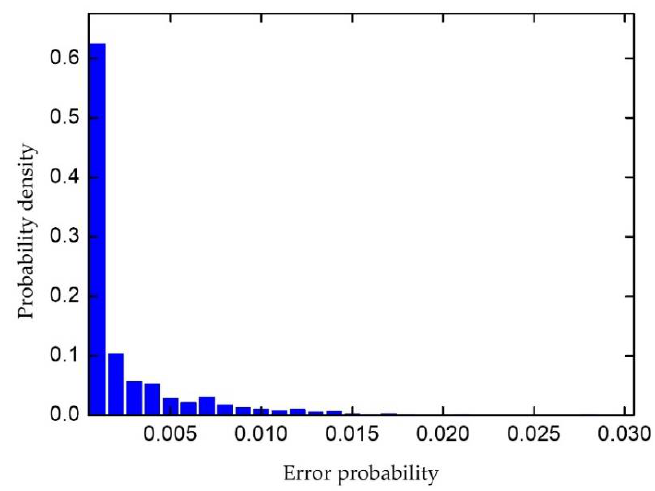
Figure 12. Probability density distribution of the wind power tracking error.